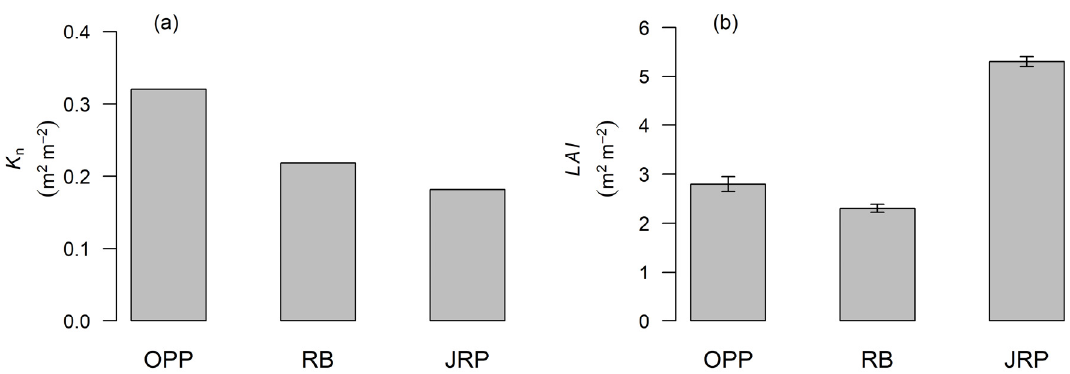
Figure 3. Estimates of light penetration in the canopy (‘ K n ’, ( a )) in oil palm plantation (OPP), rubber plantation (RB) and jungle rubber plantation (JRP). A relatively high K n value indicates a more rapid extinction of light than a relatively low K n value and implies a steeper decline in photosynthetic capacity through the canopy with respect to the leaf area index ( LAI ). Measured values of LAI ( b ) in OPP, RB and JRP.